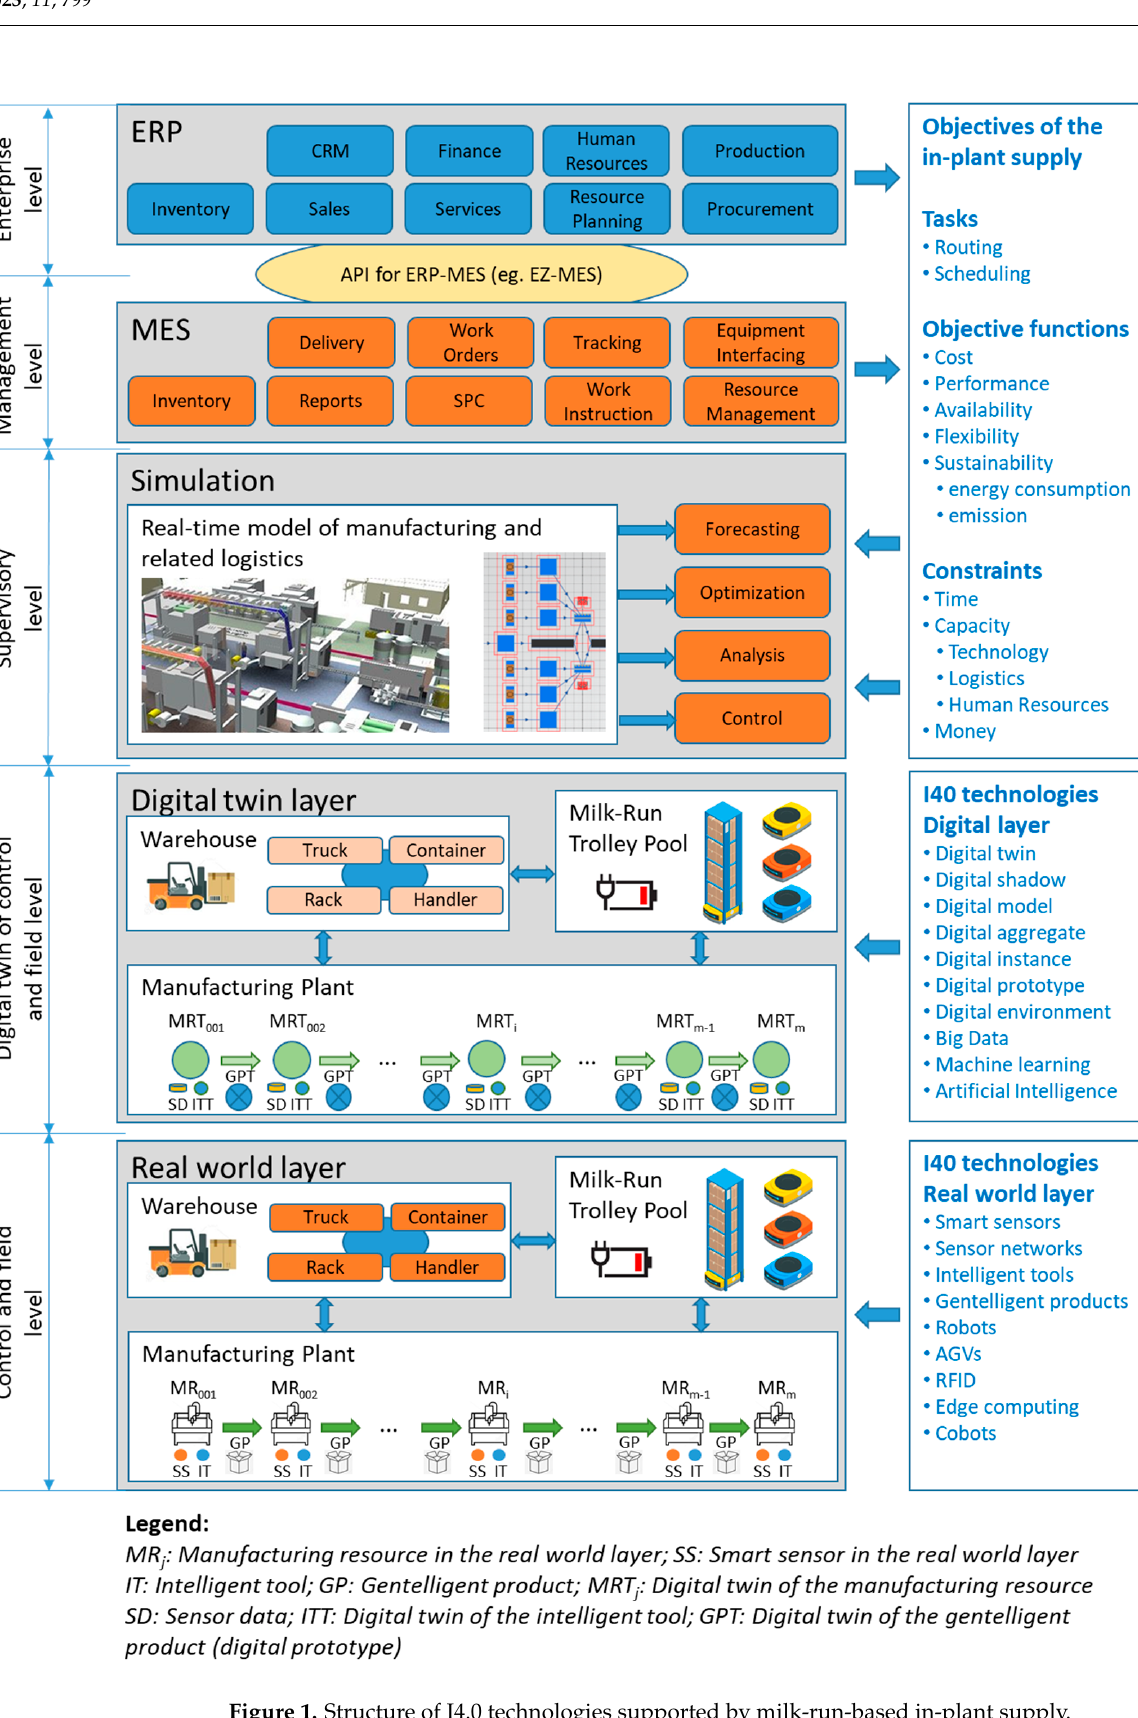
Figure 1. Structure of I4.0 technologies supported by milk-run-based in-plant supply.